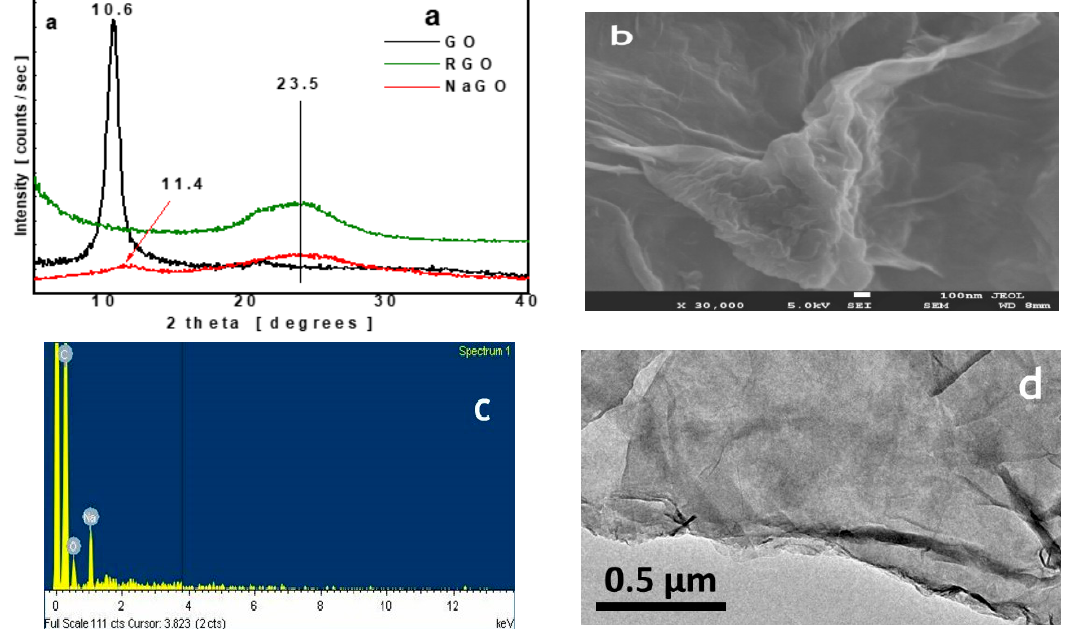
Figure 1. ( a ) XRD patterns for GO, RGO and NaGO. ( b ) SEM image for NaGO, ( c ) EDS results for NaGO and ( d ) TEM image for NaGO.